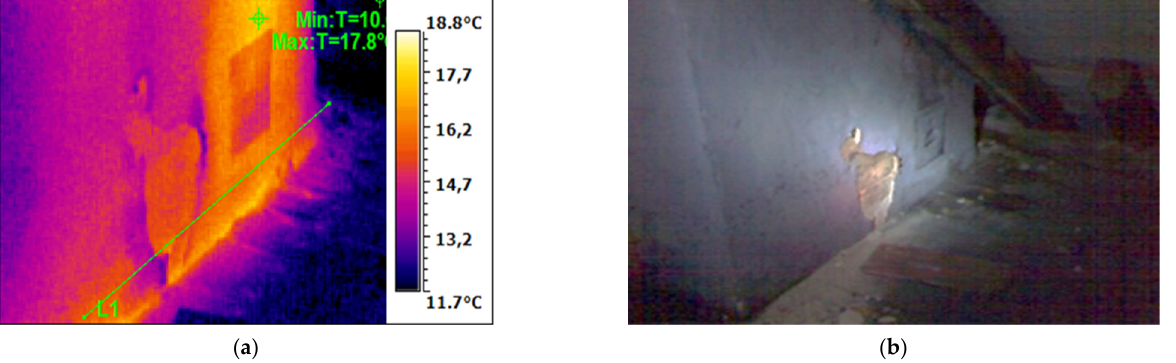
Figure 7. Thermal ( a ), and visible light ( b ) images of the chimney wall in the attic space (at the inspection grille).